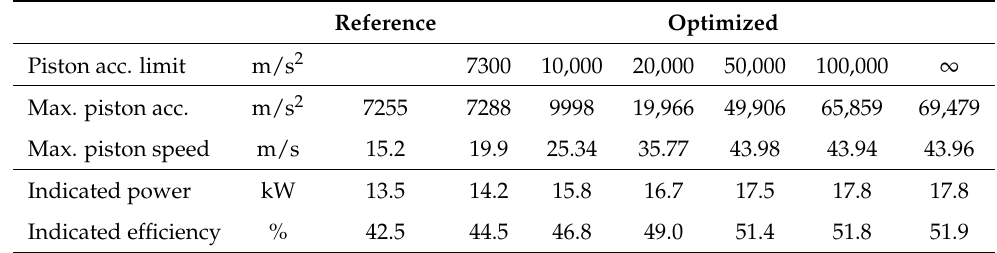
Table 2. Values for piston acceleration, power and efficiency for comparing the reference case to the optimization